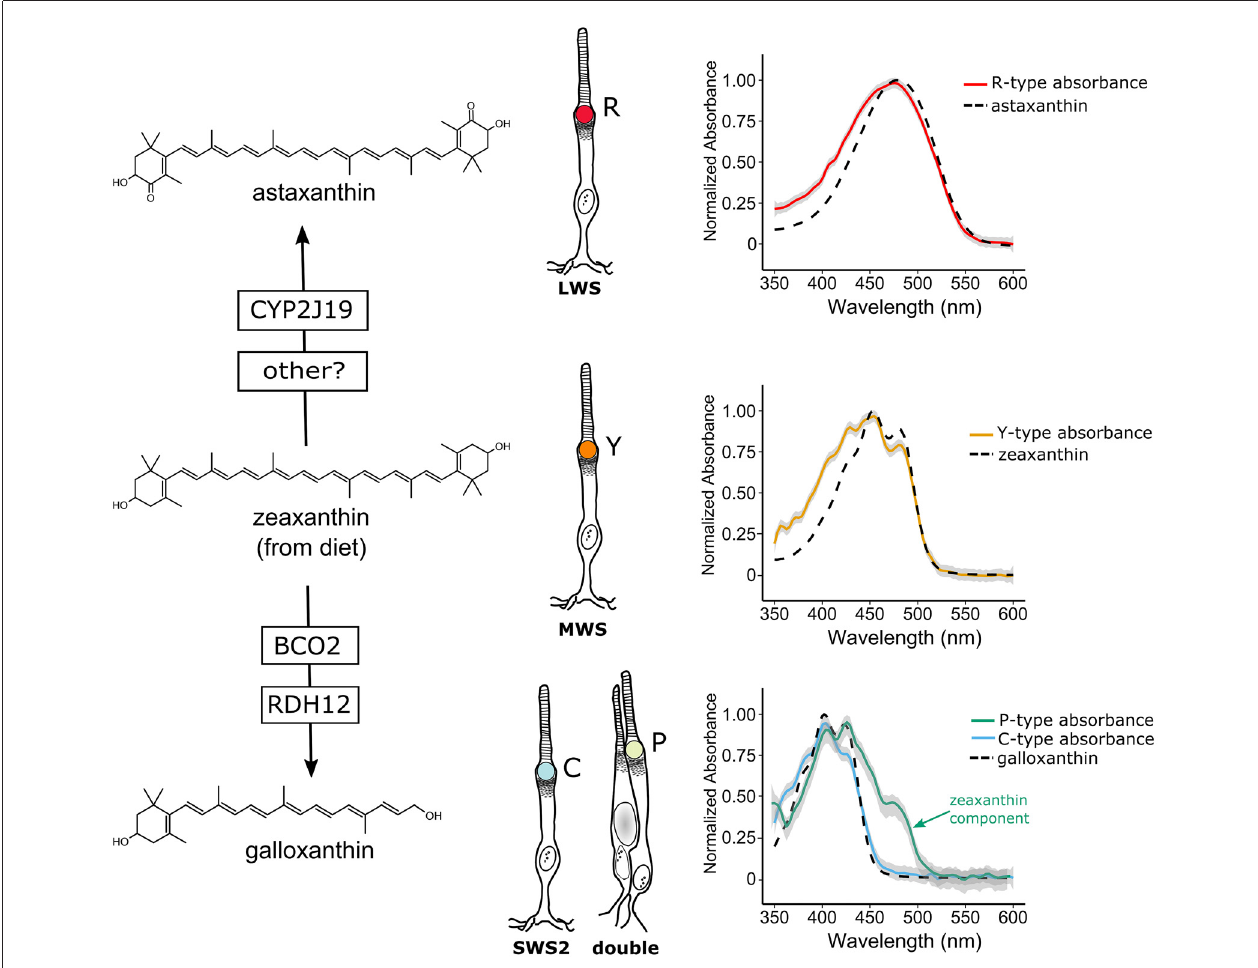
FIGURE 2 | Avian cone oil droplets are pigmented with carotenoids that are selectively metabolized in various cone photoreceptor subtypes. On the left, the molecular structure of the primary carotenoid pigments in the R-type (astaxanthin), Y-type (zeaxanthin) and the C and P-type droplets (galloxanthin) are shown. Astaxanthin is formed through the 4,4 (cid:48) ketolation of diet-derived zeaxanthin, a transformation that is thought to be mediated, at least in part, by the cytochrome P450 enzyme, CYP2J19 (Lopes et al., 2016). The apocarotenoid galloxanthin is formed through the oxidative cleavage of zeaxanthin and subsequent reduction of the resulting aldehyde. The enzymes β -carotene oxygenase 2 (BCO2) and retinol dehydrogenase 12 (RDH12) have been implicated in the formation of galloxanthin in the avian retina (Toomey et al., 2016). On the right, the light absorbance spectra of pure astaxanthin, zeaxanthin and galloxanthin are overlaid on the absorbance spectra of expanded oil droplets from each of the pigmented cone oil droplets of the chicken (shown as mean ± SD of individual normalized spectra, n = 4–5). The spectra of the oil droplets deviate somewhat from the spectra of the dominant carotenoid due to the presence of small quantities of other carotenoid types in each droplet (Toomey et al., 2015). For example, the long-wavelength shoulder seen in the P-type droplet spectrum is attributable to the presence of small amounts of lutein and zeaxanthin in addition to galloxanthin. Portions of this figure are adapted from Toomey et al.